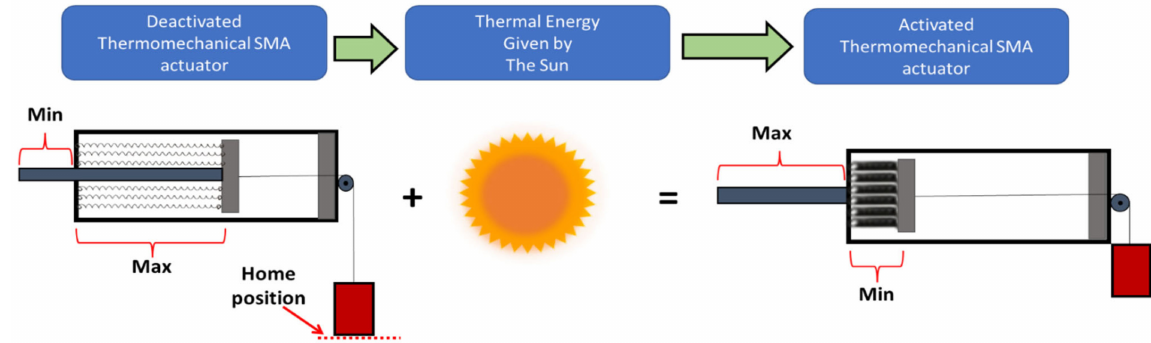
Figure 2. Basic conceptual procedures of the thermomechanical solar-based linear actuator.